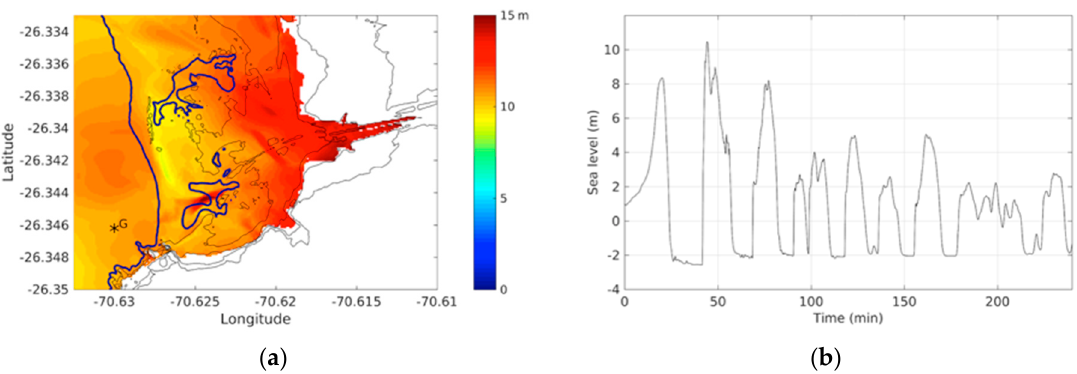
Figure 4. Results from tsunami simulations [46]. ( a ) Inundation heights. Thick black line represents the coastline, with thin lines showing contour lines at every 5 m ground elevation. ( b ) Tsunami waveform at the virtual gauge G (See Figure 3a).